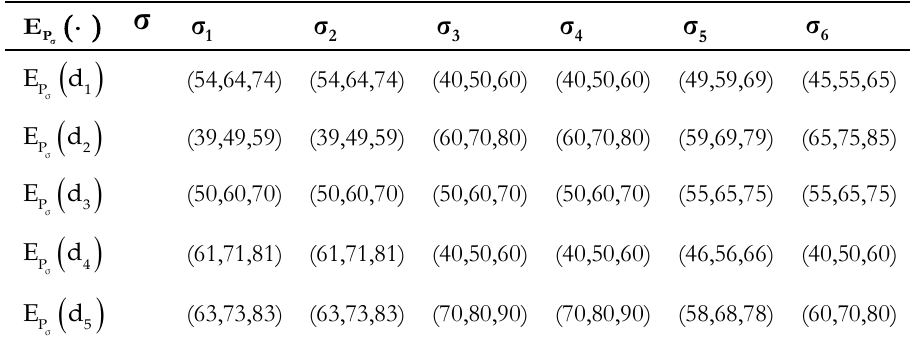
Table 3. Mathematical expectations -